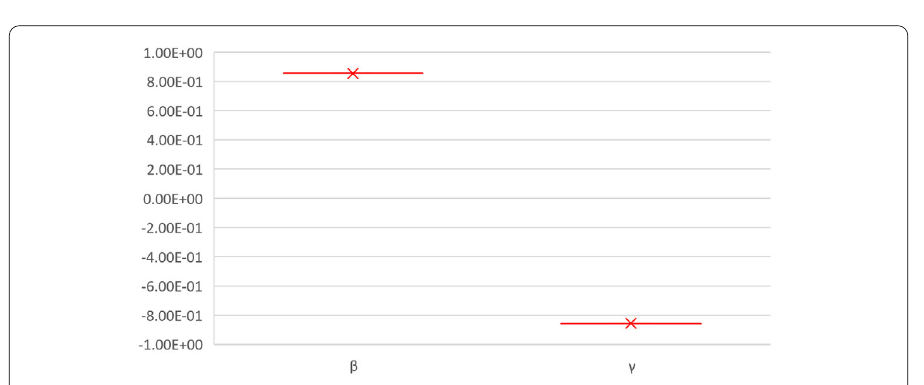
Figure 4 Normalized local sensitivity indices of R 0 for each